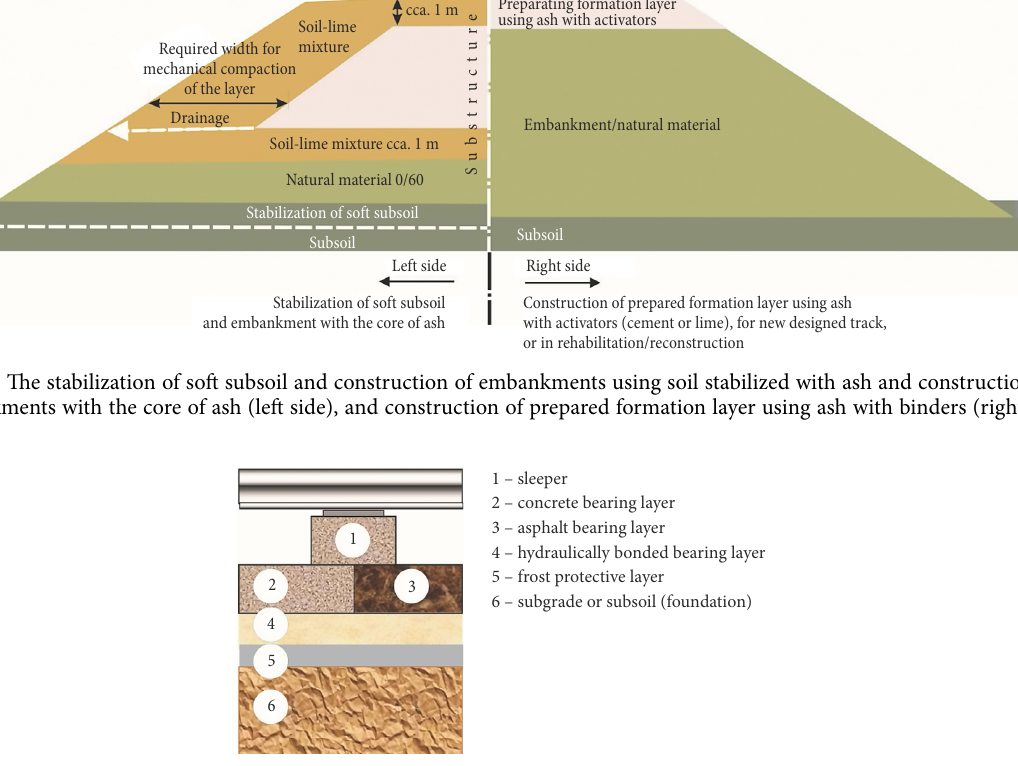
Fig. 10. Position of the hydraulically bonded bearing layer in the slab track structure